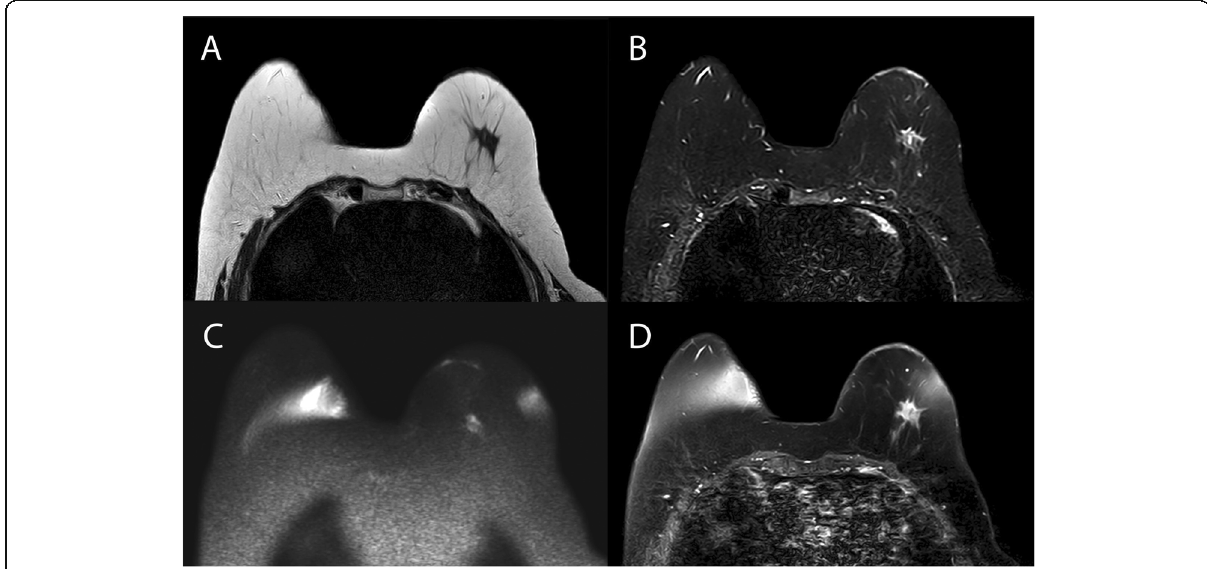
Fig. 2 A case of pathologically proven invasive duct carcinoma of the left breast. It displayed the classic appearance of an irregular speculated mass with low T1 and T2 SI ( a ), high SI in STIR ( b ), restricted diffusion in DWI ( c ), and heterogenous enhancement in post-contrast scans ( d ). It had type 3 kinetic curve consistent with malignancy. Areolar skin edema and thickening was also